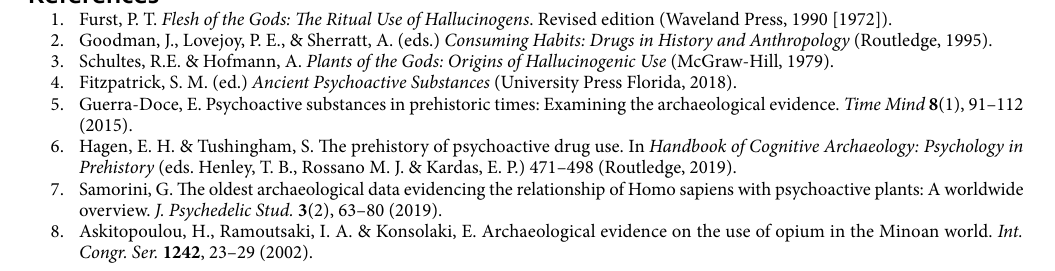
Preparation of extracts and chemical analysis. The analysis of the hair strands was carried out in accordance with relevant guidelines and regulations for prehistoric human tissue. Nitrile gloves were used during manipulation of hair in the laboratory and all equipment and glassware were washed with neutral pH detergent, distilled water and alcohol before use. A lock of hair strands was minced with the use of scissors, resulting in hair sections shorter than 1 mm. Each of three replicated hair samples (9.9, 10.1 and 10.2 mg) was washed with dichloromethane (3 × 3 mL for 10 min) and dried with a nitrogen flow. After addition of alkali to the dry extract (400 µL of aqueous 2.5 M NaOH), the suspension was sonicated for 2 h at 50° and thereafter extracted with dichloromethane (3 × 400 μL). The combined organic phases were mixed with acid (500 μL of 25 mM HCl in methanol), dried with a nitrogen flow, dissolved in methanol, and transferred to an insert inside the sample vial (100 µL final volume). The UHPLC-HRMS system consisted of an LPG-3400RS quaternary pump, a WPS-3000TRS autosampler, a TCC-3000RS column oven, a high resolution Orbitrap Exactive Plus mass spectrometric detector equipped with electrospray ionization (ESI), and Xcalibur 3.1 software, all from Thermo Scientific, Bremen, Germany. An Acquity UHPLC HSS T3 (1.8 μm particle size, 2.1 mm internal diameter × 100 mm length, Waters, Milford, MA, USA) analytical column was used. Auto sampler temperature was 4 °C, column temperature 35 °C, capillary temperature 300 °C, auxiliary gas heater temperature 200 °C, injector temperature 15 °C, injection volume 10 µL. The detector was used in the positive ion mode scanning between m/z 80 and 1000 with resolution 140,000 and the following conditions: S-lens RF level 50, spray voltage 6 kV, sheath gas flow rate 35 (arbitrary units), auxiliary gas flow rate 5 (arbitrary units), sweep gas flow rate 1 (arbitrary units). Solvents were analytical chromatographic grade (Merck, Darmstadt, Germany). The mobile phases were: A) 20 mM ammonium acetate + 0.1% formic acid in aqueous solution, and B) 20 mM ammonium acetate + 0.1% formic acid in acetonitrile solution. The linear gradient program [time (min), %A] was: [0, 98], [4, 98], [6, 5], [7, 98] and [10, 98]. Approximate concentrations of alkaloids in hair were estimated from calibration lines obtained with neat standards at 0.1, 1, 10, 100, and 1000 pg/µL. The limit of detection for each alkaloid was defined as the minimum concentration of standard solution where signal-to-noise (S/N) ratio was less than 3 in the interval ± 2 min around the alkaloid peak. Similarly, the limit of quantitation for each alkaloid was defined as the minimum concentration of standard solution where S/N was less than 10. Data availability All data generated during this study are included in this manuscript.